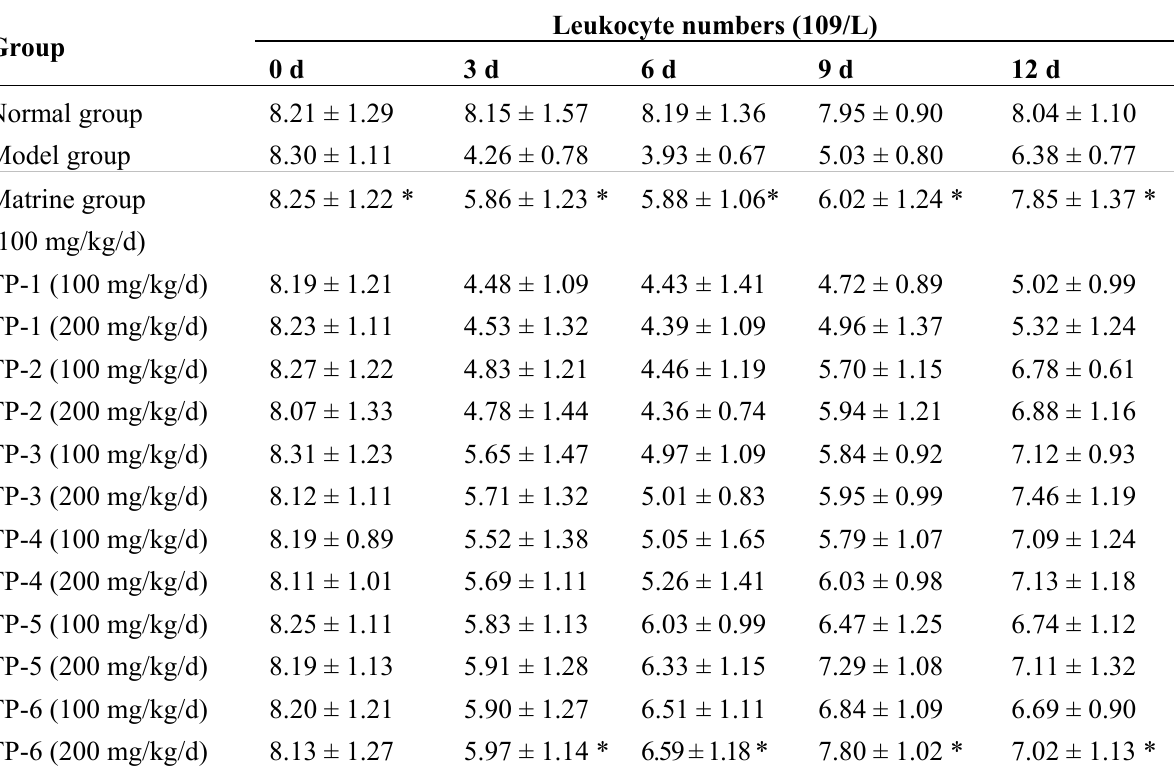
Table 3. Accelerated recovery from cyclophosphamide-induced leucopenia in rats ( X ± SD, n = 10).